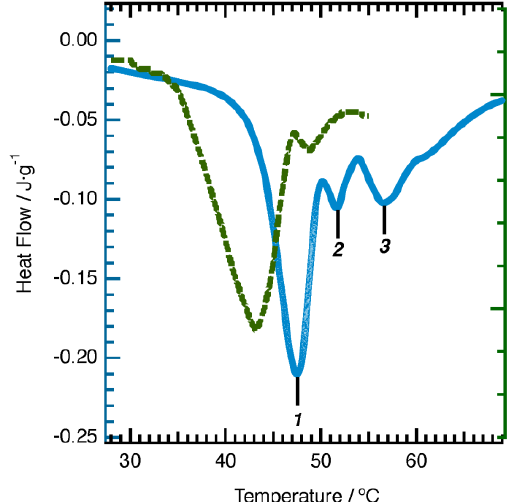
Figure 4. DSC data for the PHTrp-Cu hydrogel. The dotted line represents the data for the C18ADPA hydrogel [17].